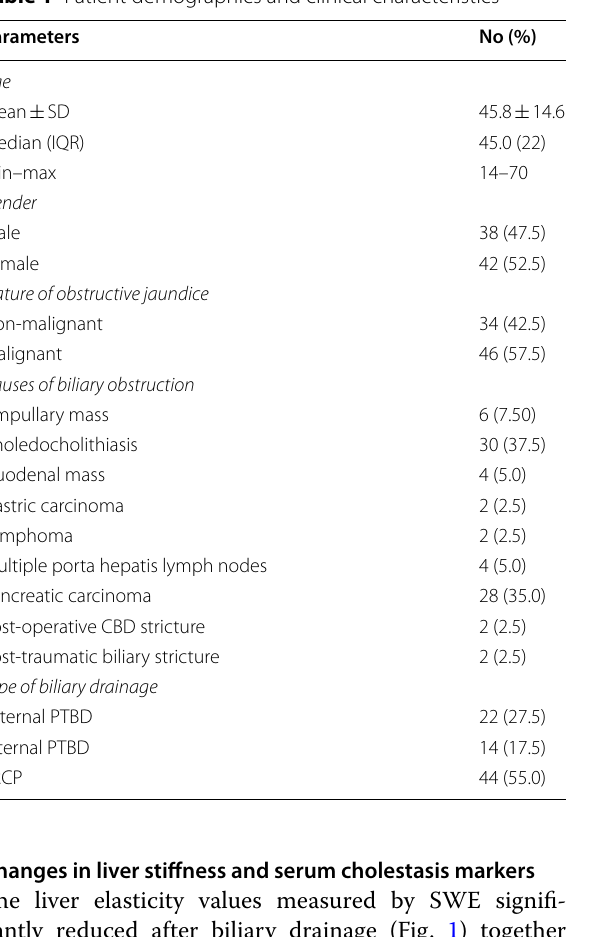
Table 1 Patient demographics and clinical characteristics